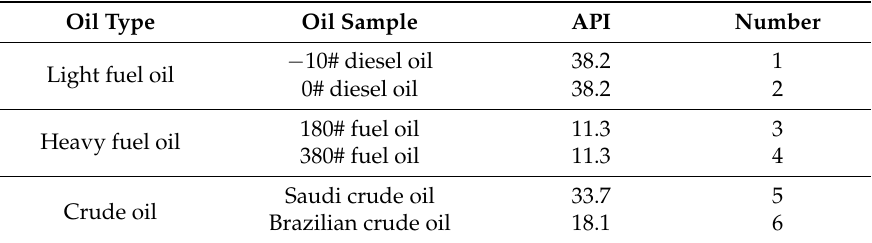
Table 2. Oil samples used in this paper.